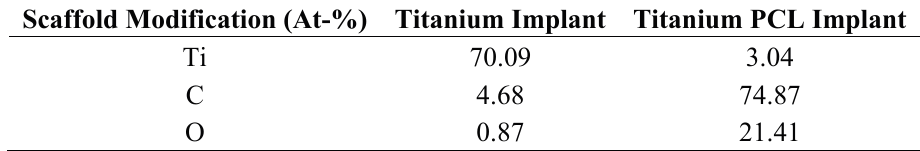
Table 1. Surface composition of titanium implants and titanium PCL implants analyzed by EDX measurement. The relevant elements titanium, carbon and oxygen (Ti, C and O) described in atomic percent (At-%) are listed.